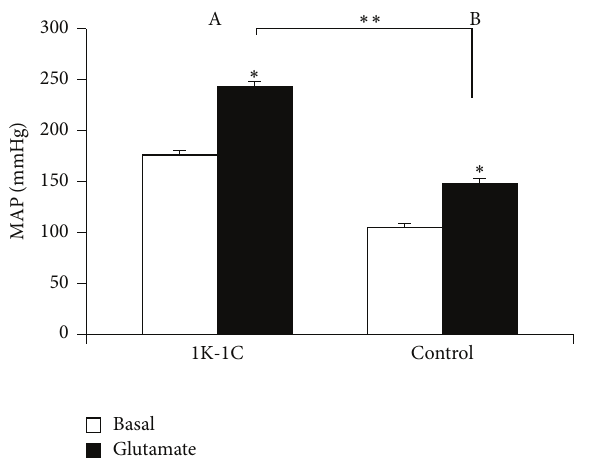
Figure 2: Values of mean arterial pressure (MAP) reached after bilateral microinjection of candesartan (0.01mol/L, 100 nL) into the RVLM in 1K-1C ( 𝑛 = 5 ) or control rats ( 𝑛 = 5 ). ∗ 𝑃 < .05 in relation to basal